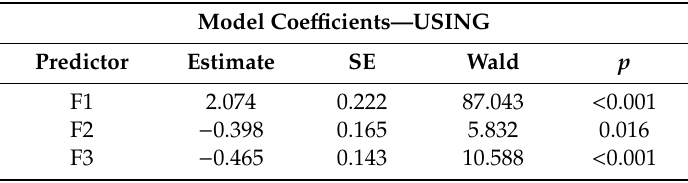
Table 3. Parameter estimates of the ordinal regression.